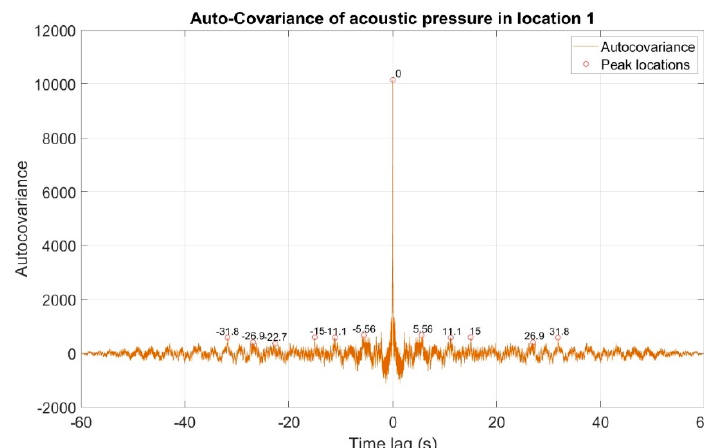
Figure 10. Course of auto-covariance function of infrasound signals generated by the investigated wind turbine, recorded in measuring setup number 1.